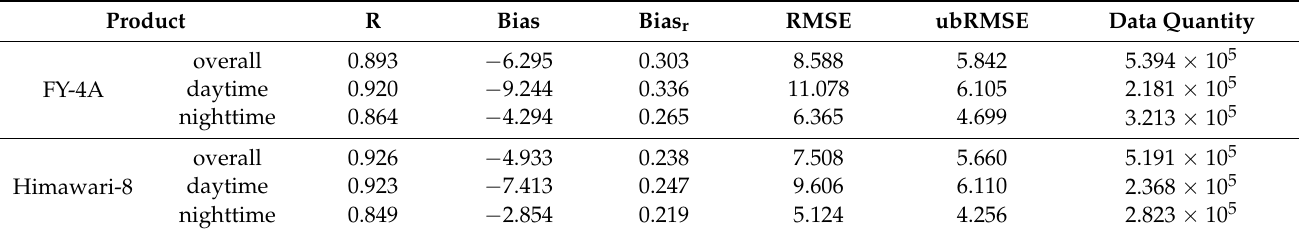
Table 2. Error parameters for comparison between FY-4A LST and Himawari-8 LST tested against in situ measurements.